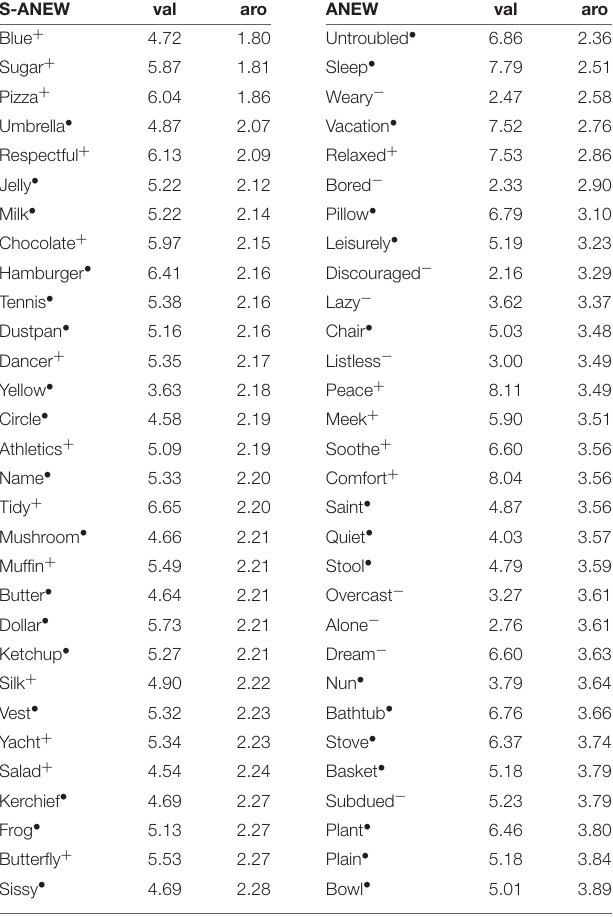
TABLE 5 | The thirty lowest arousal rated words. S-ANEW